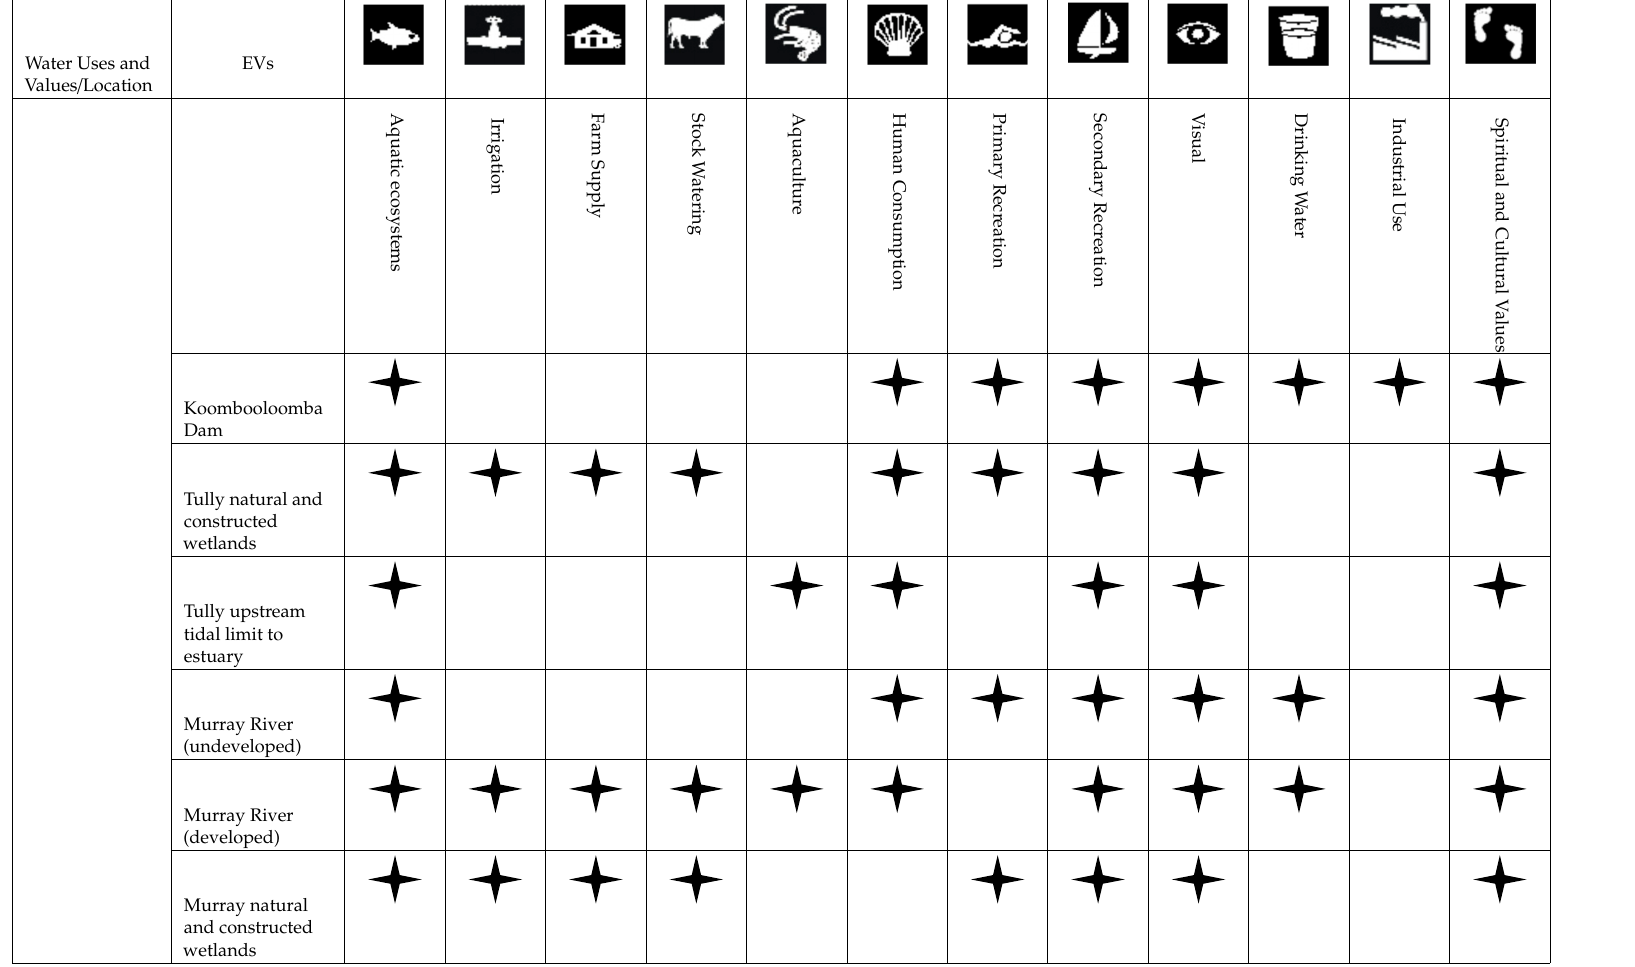
Table A1. List of EVs * Summarised for the Tully Basin EVs (as a result of this current research.